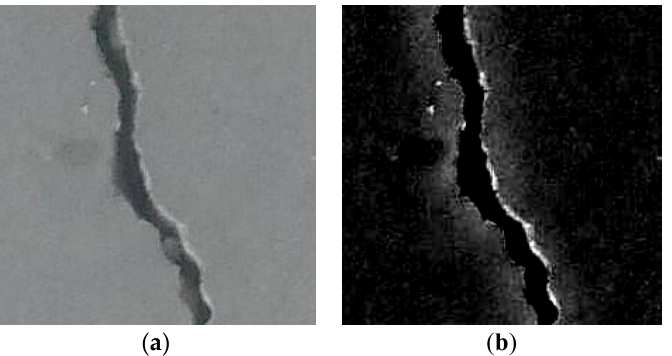
Figure 1. An example of edge pixel enhancement: ( a ) the original color image; ( b ) result of edge pixel enhancement.